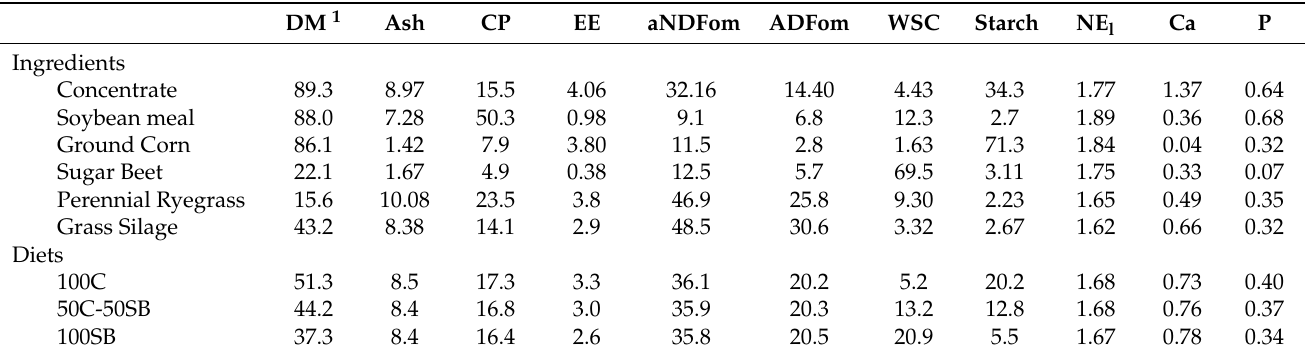
Table 1. The nutrient concentrations of the feed ingredients and diets (% on DM basis if not other- wise